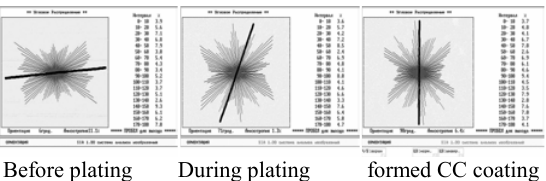
Fig 8. Orientation of blocs of CC coating structure concerning main operating strains